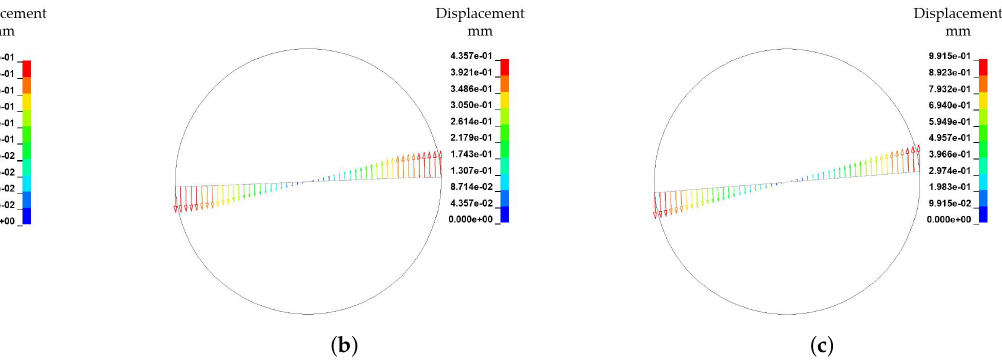
Figure 22. Fibre displacement by different angle velocity ω at T = 0.4s. ( a ) Fibre displacement by ω = 0.2s − 1 . ( b ) Fibre displacement by ω = 0.4s − 1 (Reference). ( c ) Fibre displacement by ω = 0.8s − 1 .